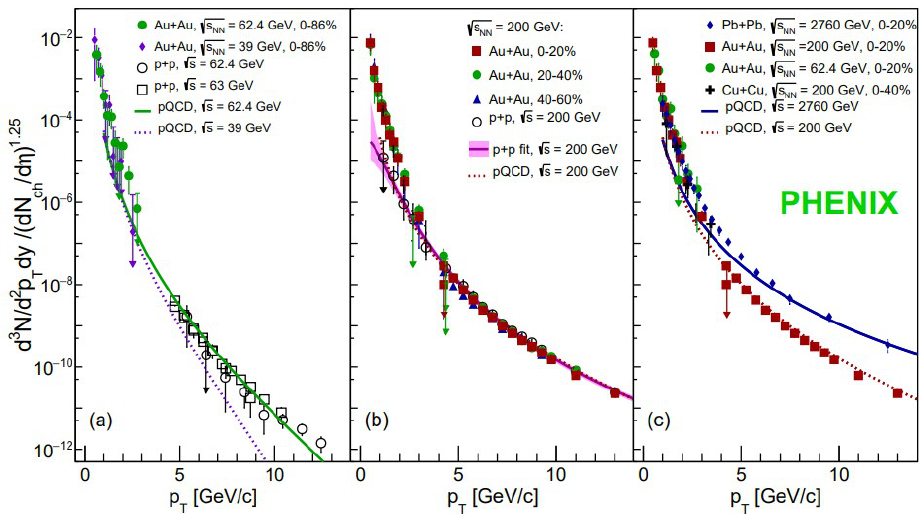
Figure 2. Differential yields of the direct photons measured in different collision systems as a function of transverse momentum. The yields are divided by the changed particle multiplicity density to the power of 1.25 to reveal the scaling discussed in the